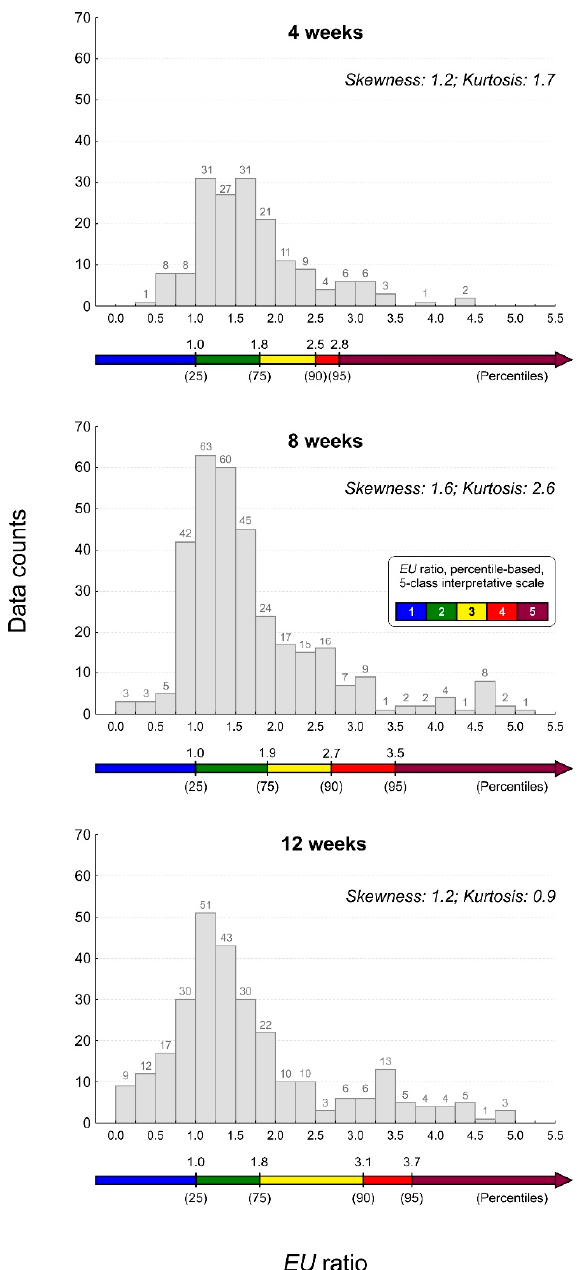
Figure 2. EU ratio data distribution with indication of data counts per interval, skewness and kurtosis, and percentile values corresponding to the thresholds defining five bioaccumulation classes. Data are separately reported for different transplant exposure time spans (from the top to the bottom: 4, 8, and 12 weeks).